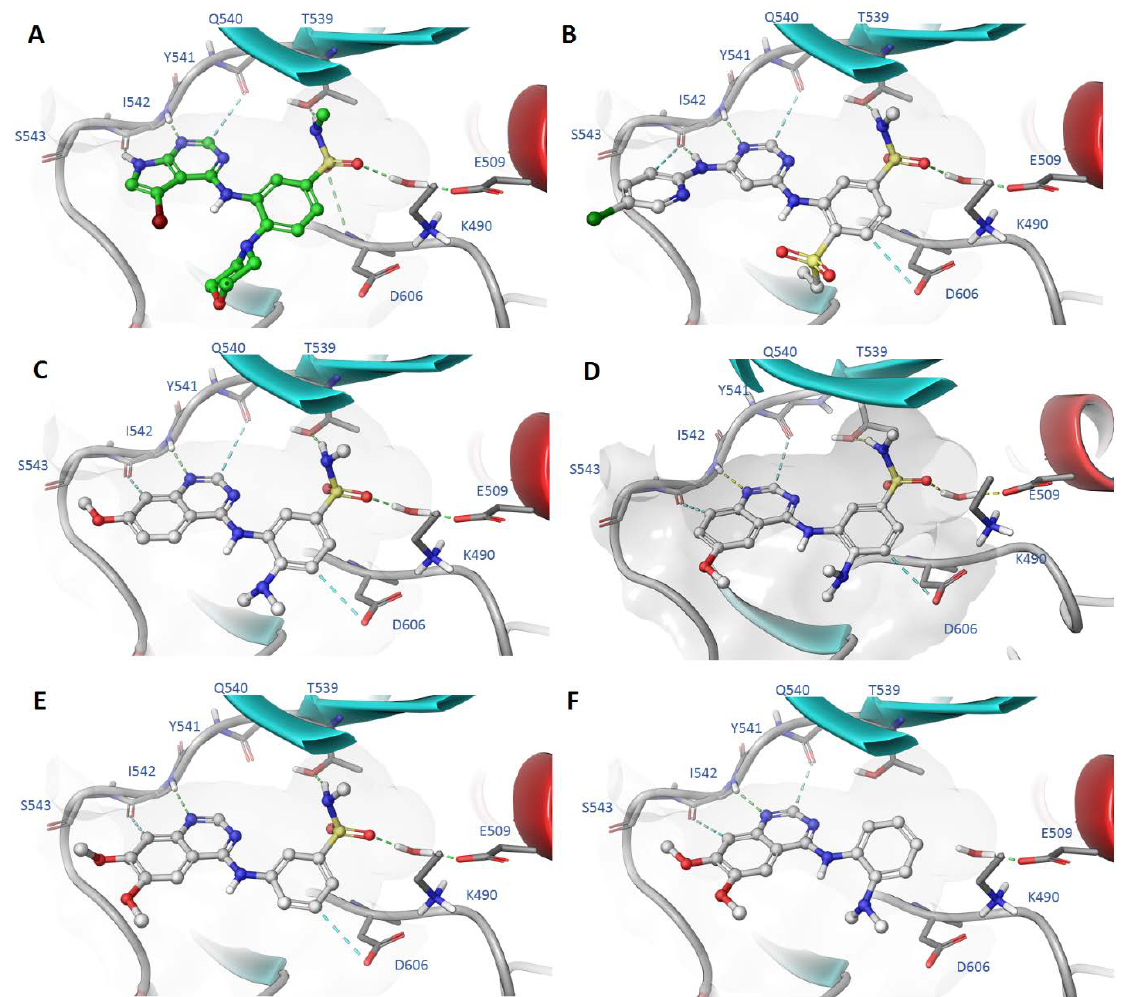
Figure 4. Modelling of compounds 6 ( A ), 8 ( B ), 17 ( C ), 16 ( D ), 2 ( E ) and 20 ( F ) docked in the TNNi3K ATP binding site (PDB: 4YFF).